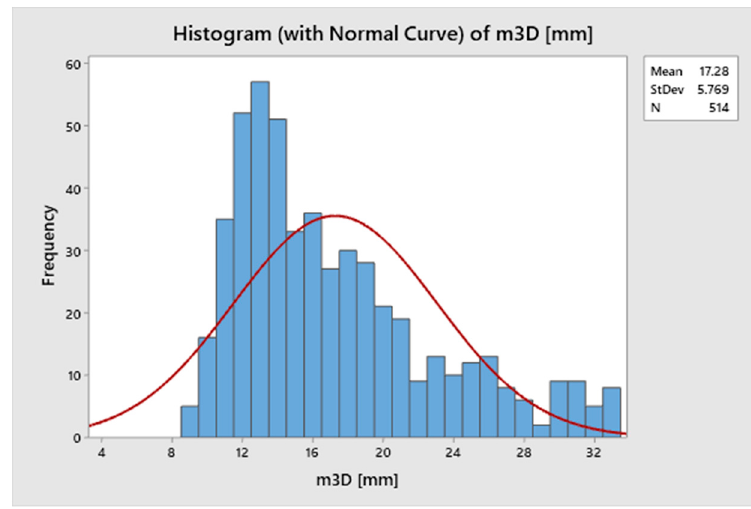
Figure 6. Histogram (with Normal Curve) of m 3D [mm].